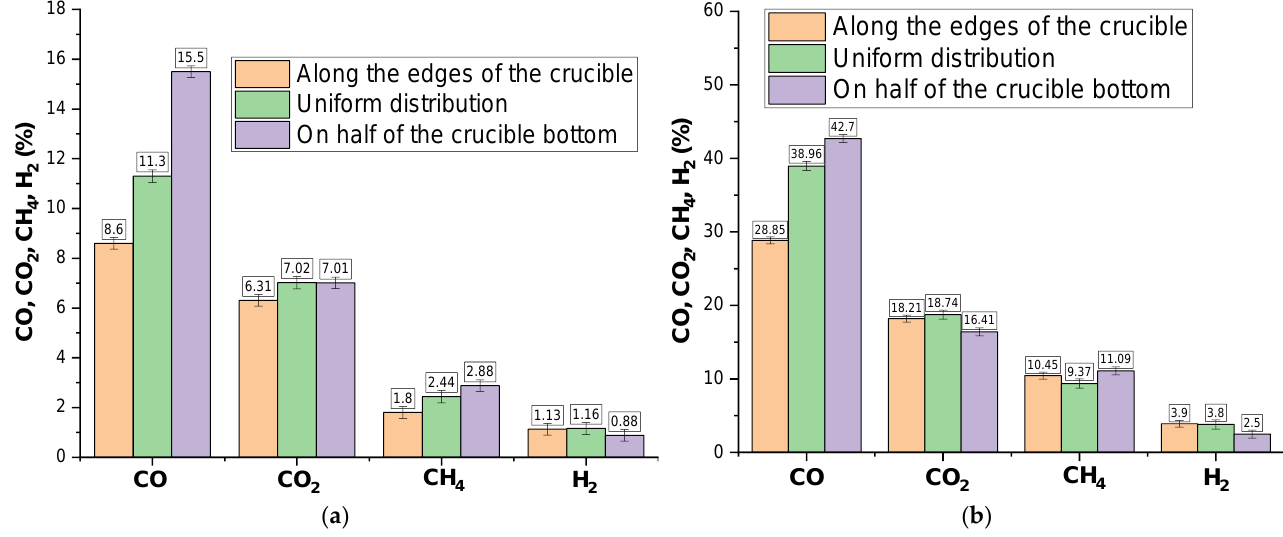
Figure 5. Average ( a ) and maximum ( b ) concentrations of gas mixture components for different distributions of biomass.